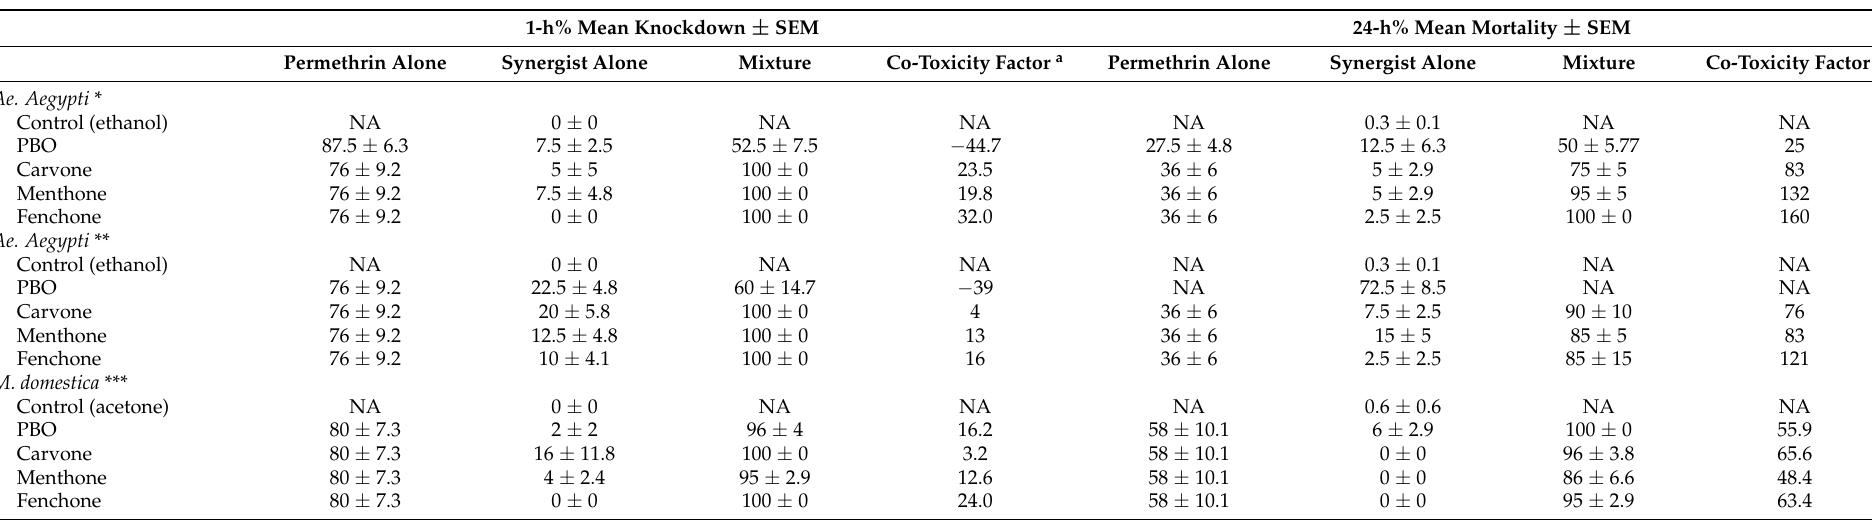
Table 2. Diagnostic doses and co-toxicity of L -carvone, L -menthone, and L -fenchone with permethrin against Aedes aegypti and Musca domestica .